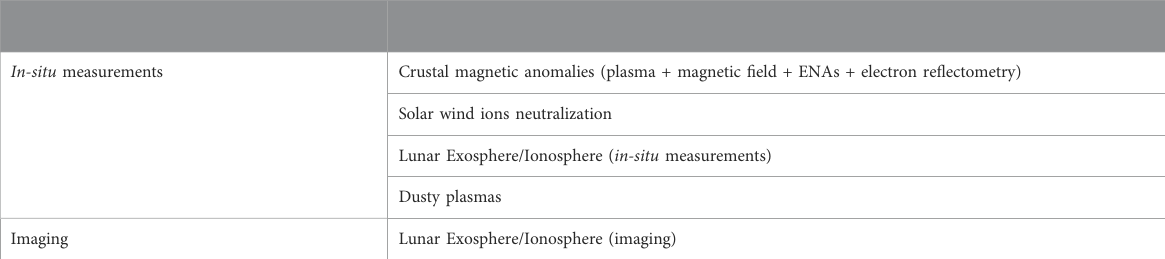
TABLE 2 Physical parameter/observable to be monitored from low lunar orbits.